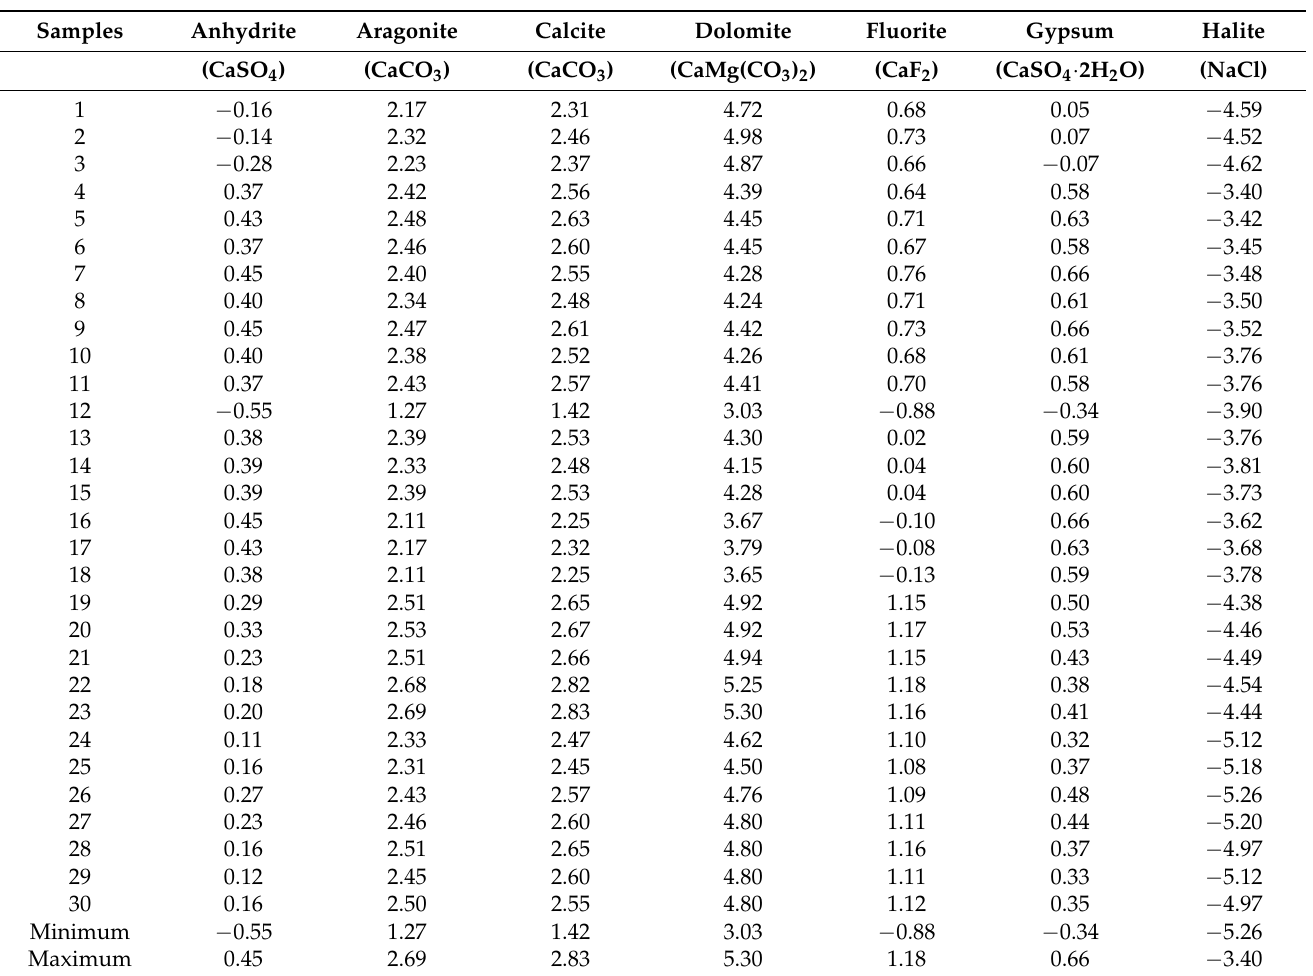
Table 4. Saturation indices calculated for different types of